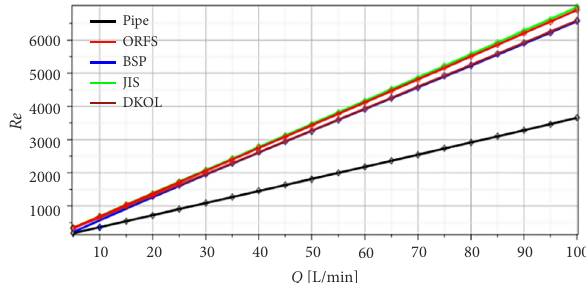
Figure 8. Mesh resolution of the mesh independence study: